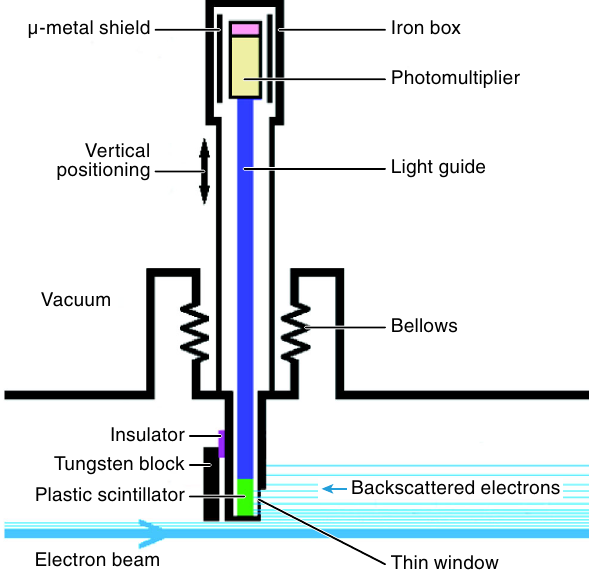
FIG. 5. Not-to-scale schematic of the eBSD scintillation de- tector and its housing. Electrons backscattered by the relativistic ion beam reach the plastic scintillator after traversing a thin titanium alloy vacuum window. The light from the scintillator is converted to electrical signals by means of a well shielded photomultiplier tube. A tungsten block protects the back of the detector cavity from accidental heating by the electron beam.